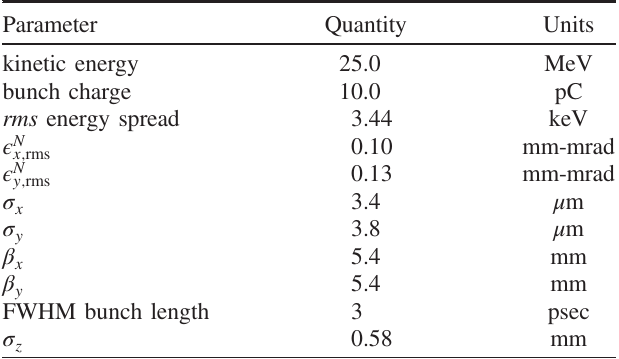
TABLE IV. Properties of electron bunch at the collision